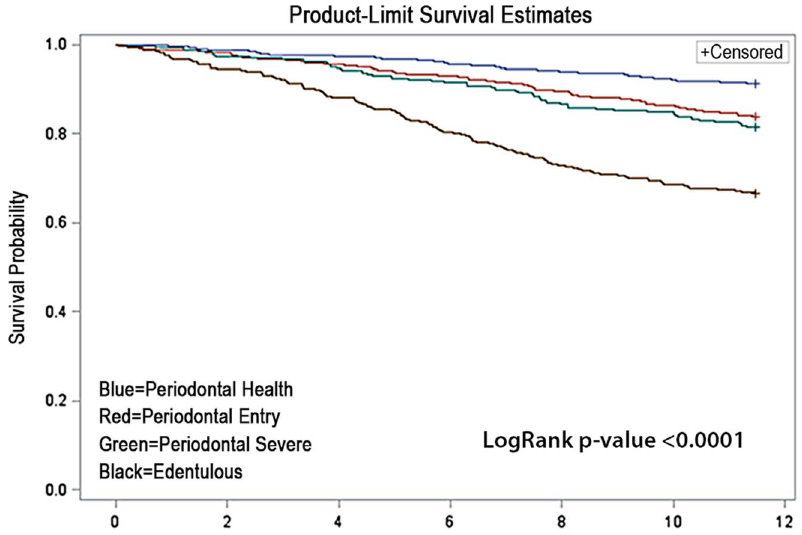
Figure 2. Product-Limit Survival Estimates.